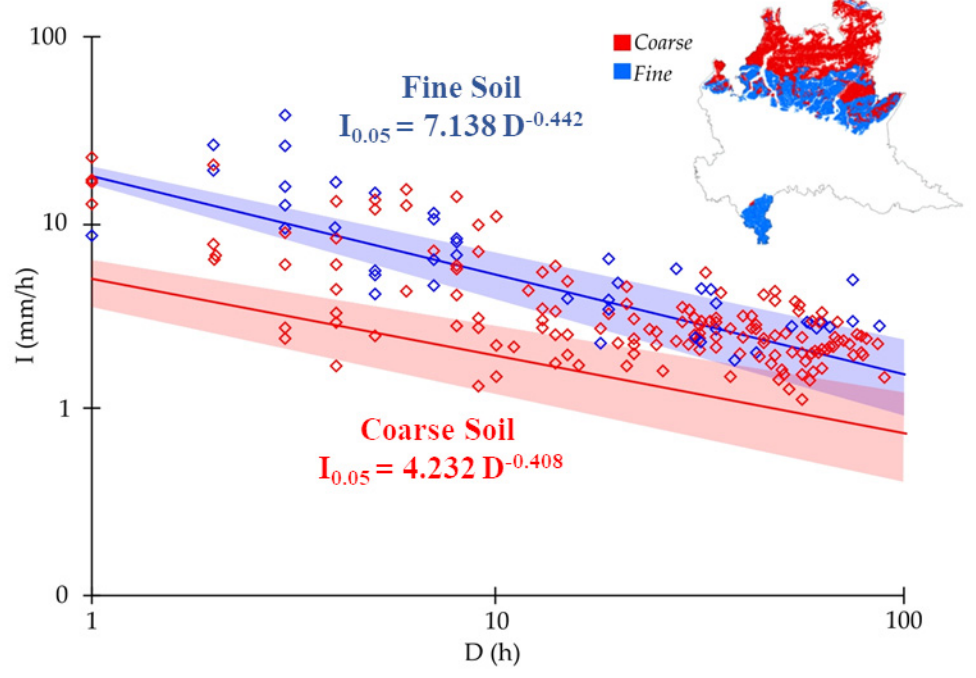
Figure 9. Rainfall intensity–rainfall duration (ID) thresholds for fine- and coarse-textured soils (see Table 5). Colored lines are 5% power law thresholds. Shaded areas between dashed lines show the 95% confidence intervals of the threshold curves.